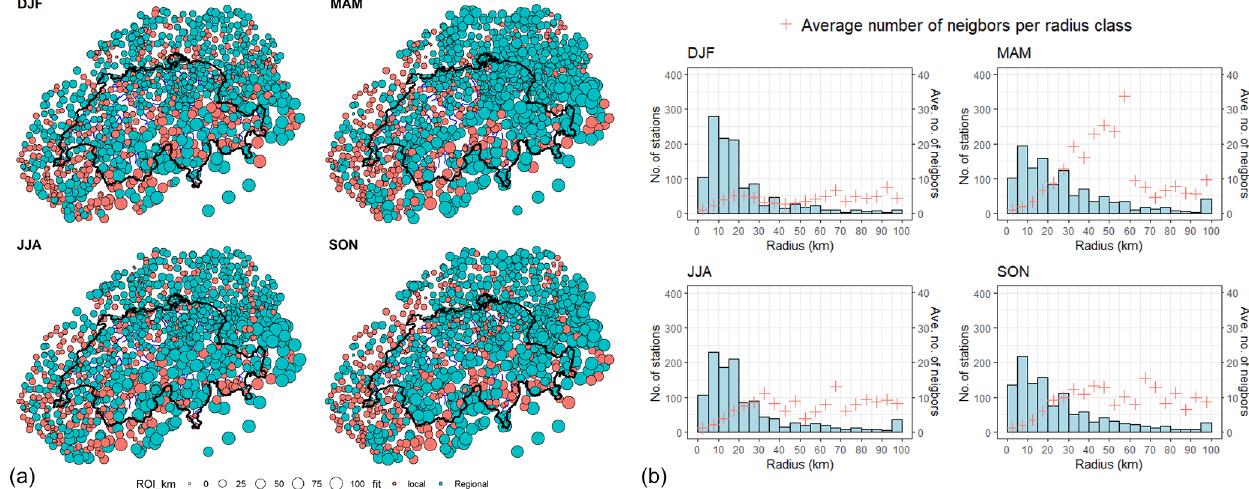
Figure 3. Properties of the ROI identified for each station. (a) Seasonal maps showing the size of the ROI per station. For each season, the size of the circle is proportional to the ROI size: the smallest is 0 (km), and the largest is 100 (km). The color of the circle indicates whether a local fit is done or a regional fit. (b) Histogram of the size of the ROI identified. The red points indicate the average number of neighbors identified for each ROI